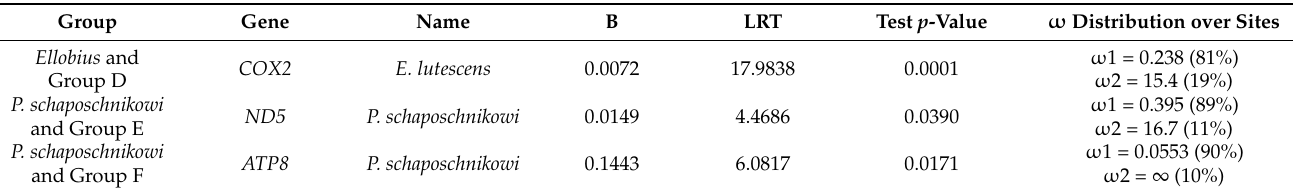
Table 2. Estimation of ω using aBSREL. Name-branch of interest, B-optimized branch length, LRT-likelihood ratio test, Test p -value corrected for multiple testing.